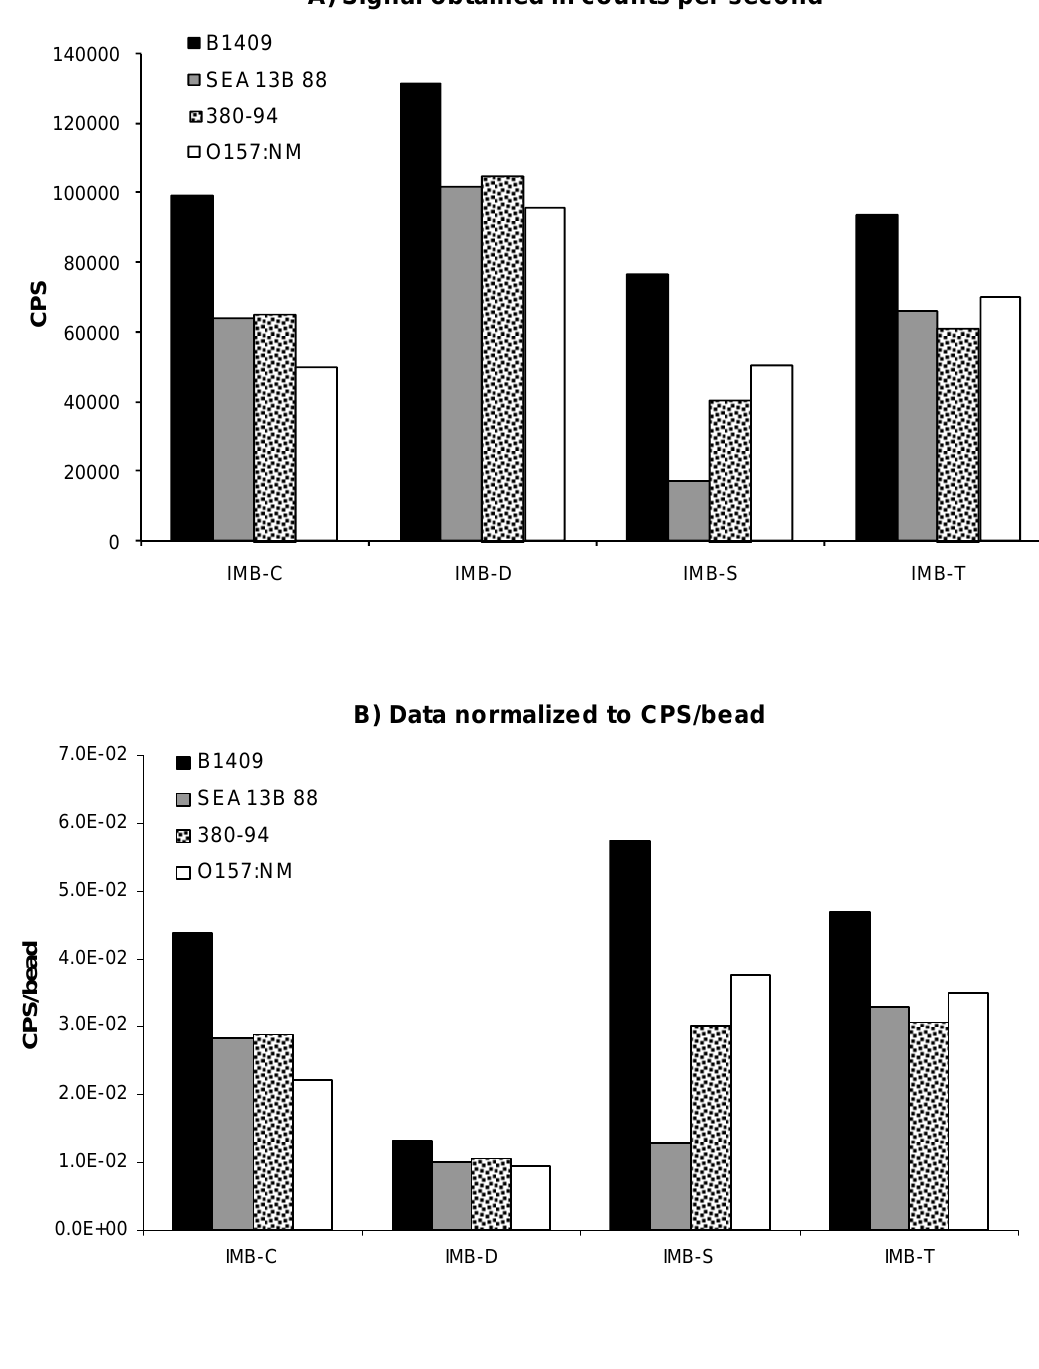
Figure 1. Response obtained using 2.6–2.8  m IMB in the capture of 1×10 7 cells/mL of E. coli O157:H7 and E. coli O157:NM from suspension. A) shows the data obtained in counts per second (CPS) while B) shows the results normalized to the number of beads used per assay. The average percent error among replicates was